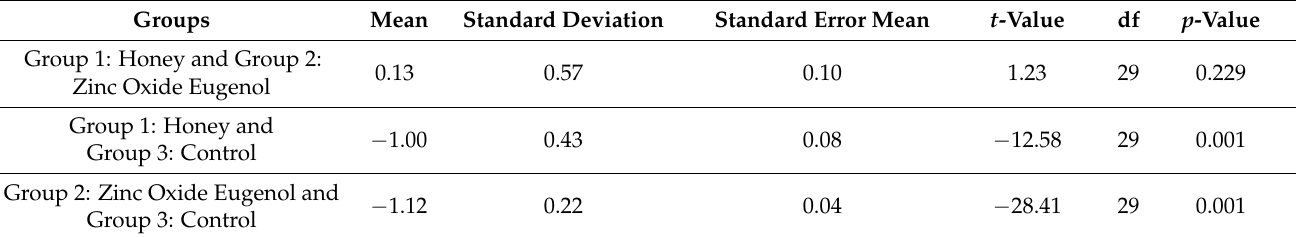
Table 4. Comparison of VAS scores among the three groups using paired t -test.